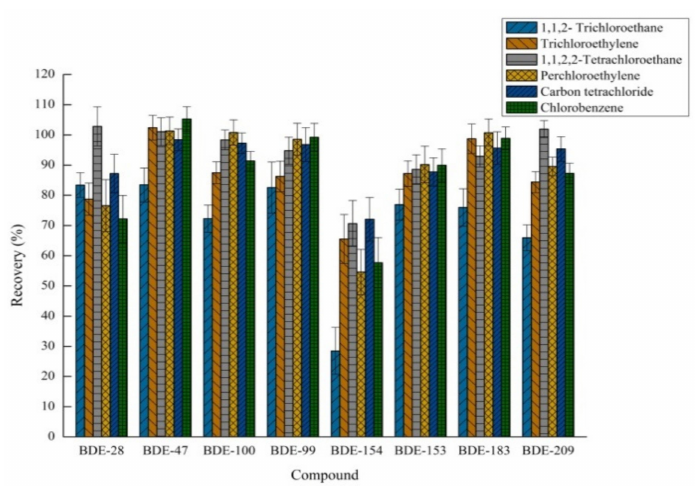
Figure 1. Effect of the type of extraction solvent on recovery ( n = 3).